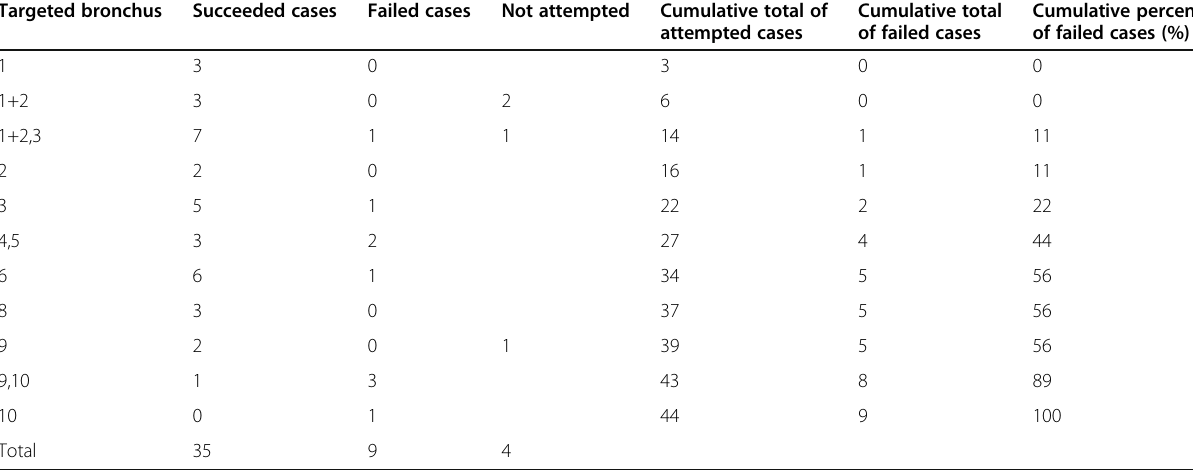
Table 3 Targeted bronchus and success of the bronchoscopic jet ventilation method Targeted